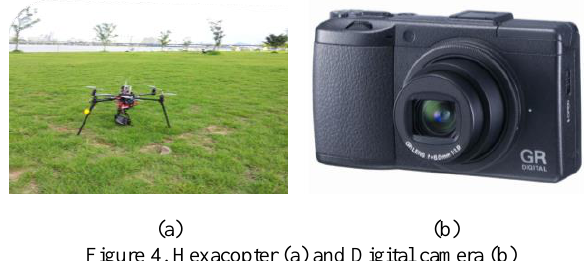
Figure 4. Hexacopter (a) and Digital camera (b)